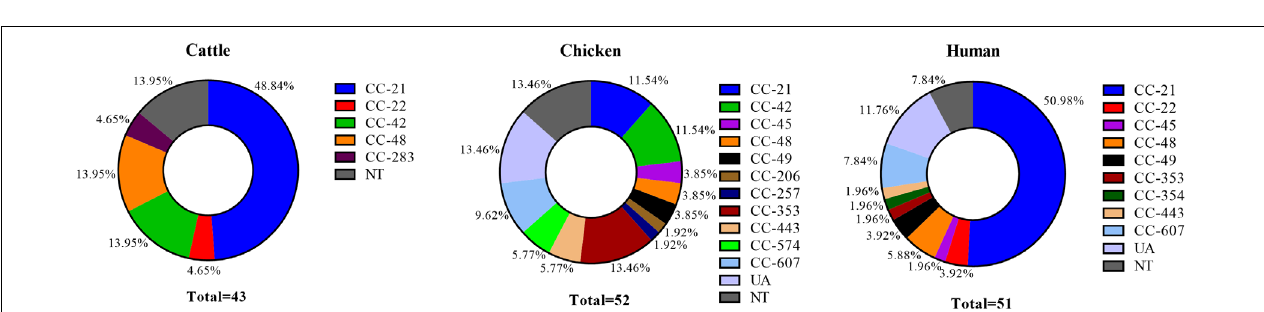
FIGURE 1 | UPGMA dendrogram based on virulence profile types. Virulence-associated genes for each type are indicated in different colors for each gene. Blank, not detected.